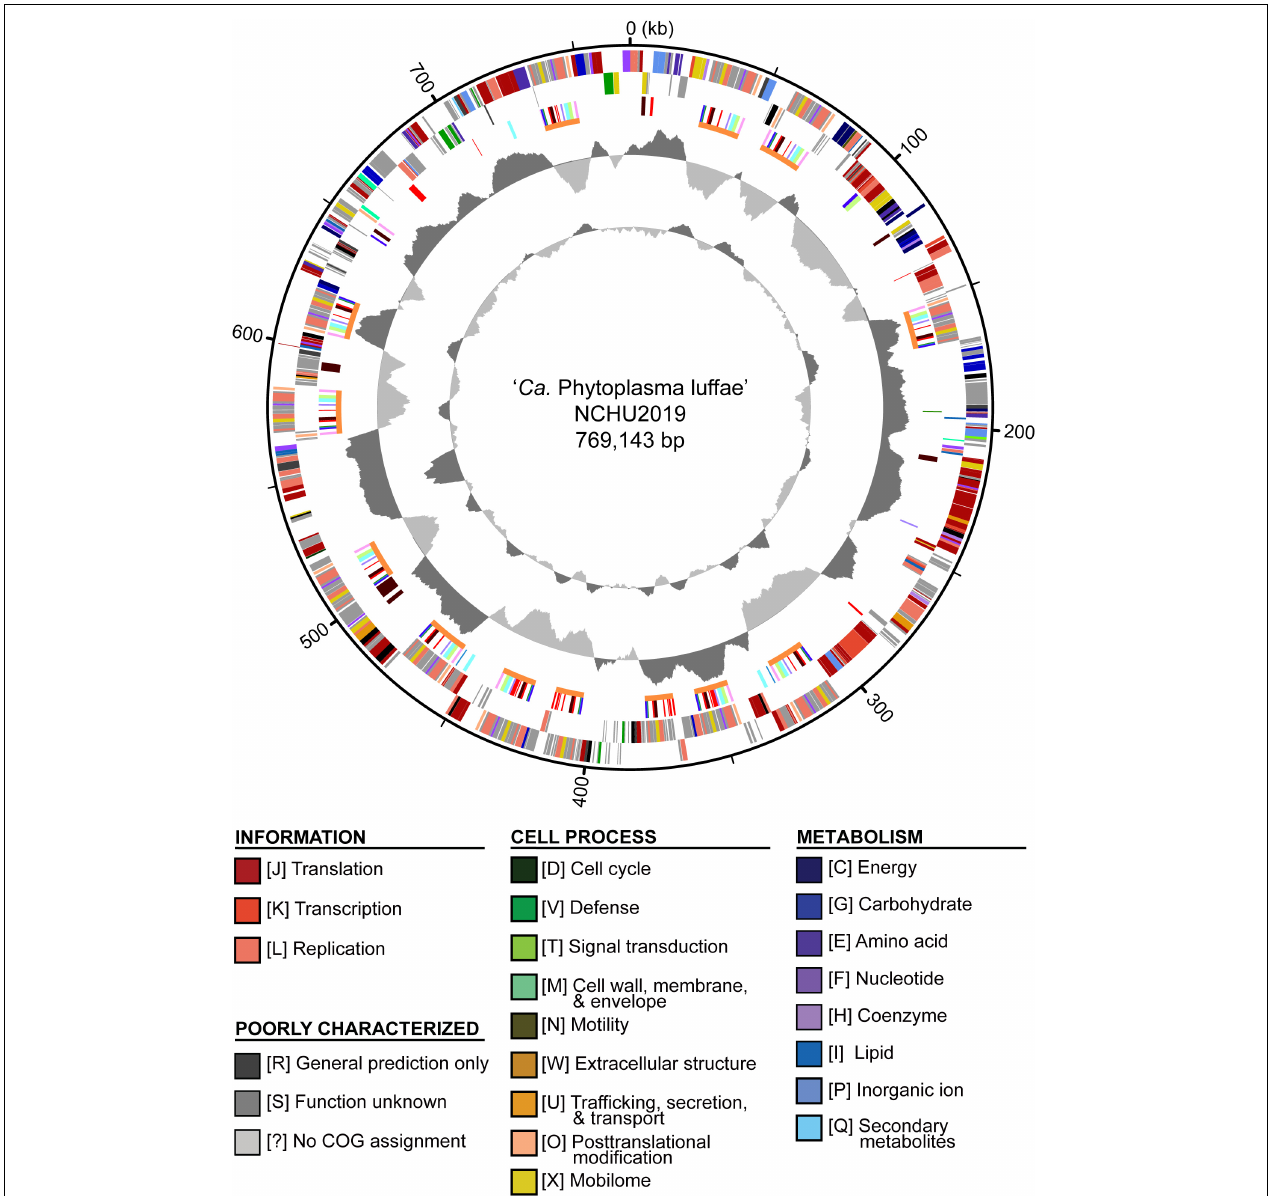
FIGURE 2 | Genome map of ‘ Candidatus Phytoplasma luffae’ NCHU2019. Rings from outside in: (1) Scale marks (kb). (2 and 3) Coding sequences on the forward and reverse strand, respectively. Color-coded by functional categories. (4) Genes associated with potential mobile units (PMUs), color-coded by annotation (see Figure 5 ). Gene clusters that represent individual PMUs are labeled by orange lines. Genes encoding putative secreted proteins are in red. (5) GC skew (positive: dark gray; negative: light gray). (6) GC content (above average: dark gray; below average; light gray). One high GC peak located in the 531–544 kb region corresponds to two adjacent rRNA